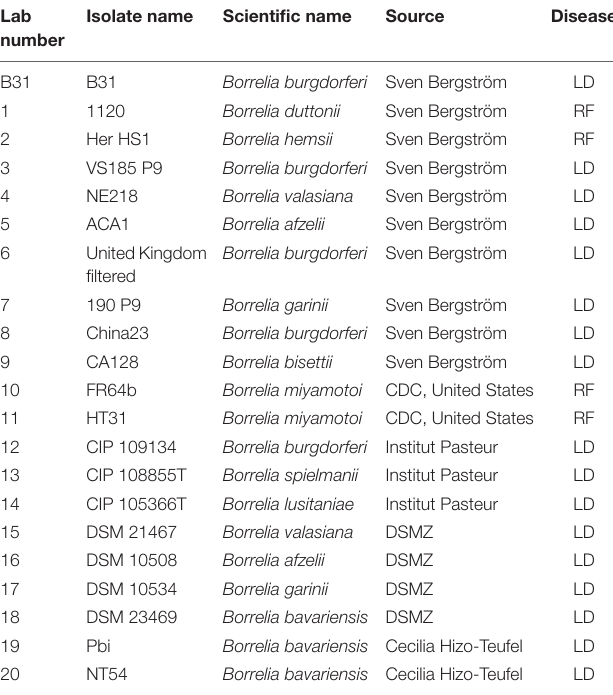
TABLE 2 | Borrelia strains used in this